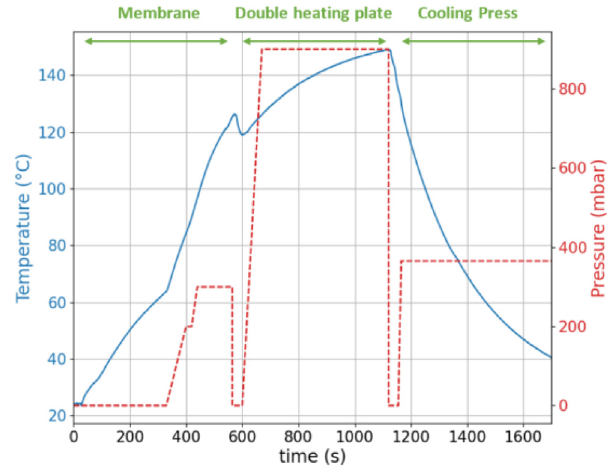
Fig. 1. Typical lamination process parameters used for Si-cells PV modules, with Cooling Press step.